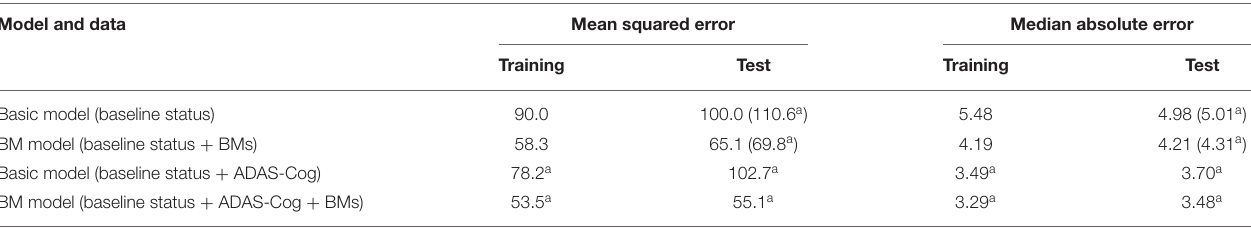
TABLE 2 | Predictive accuracies of predicted ADAS-Cog total score trajectories for the basic model and the biomarker model both with and without the baseline ADAS-Cog total score. Model and